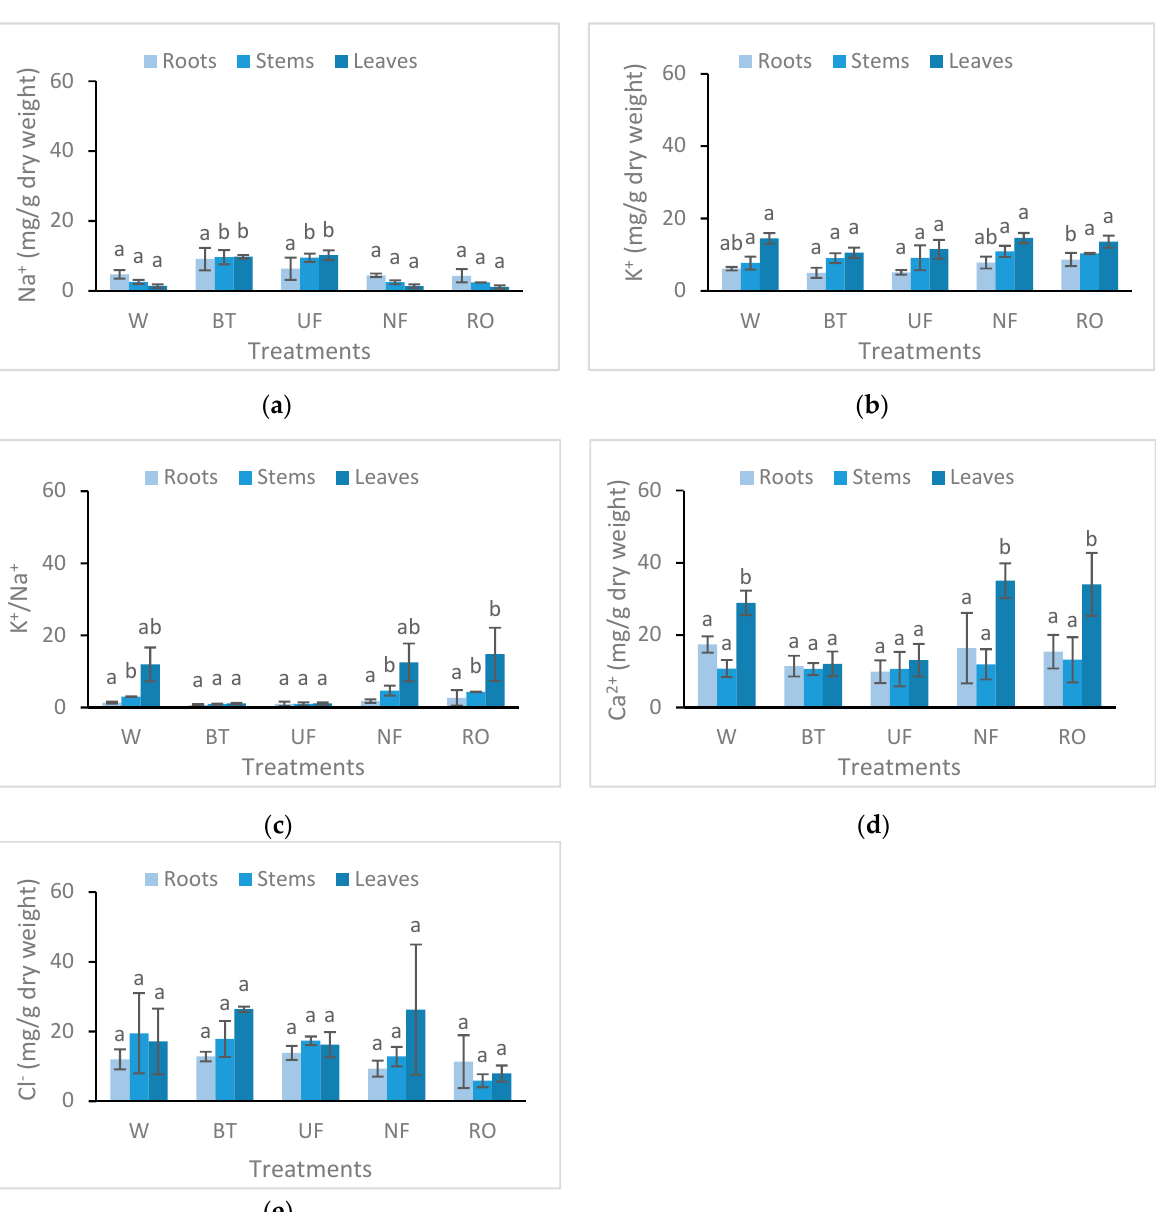
Figure 5. E ff ects of TTE on the mineral nutrition of Sesbania plants. ( a ) Na + concentration; ( b ) K + concentration; ( c ); K + /Na + ratio; ( d ) Ca 2+ concentration; and ( e ) Cl − concentration. W: Well water; BT: Biological treatment; UF: Ultra fi ltration; NF: Nano fi ltration; and RO: Reverse Osmosis. The means of three observations (± standard deviation) followed by the di ff erent le tt ers in each organ are signi fi cantly di ff erent according to Tukey’s test at the level of p < 0.05.